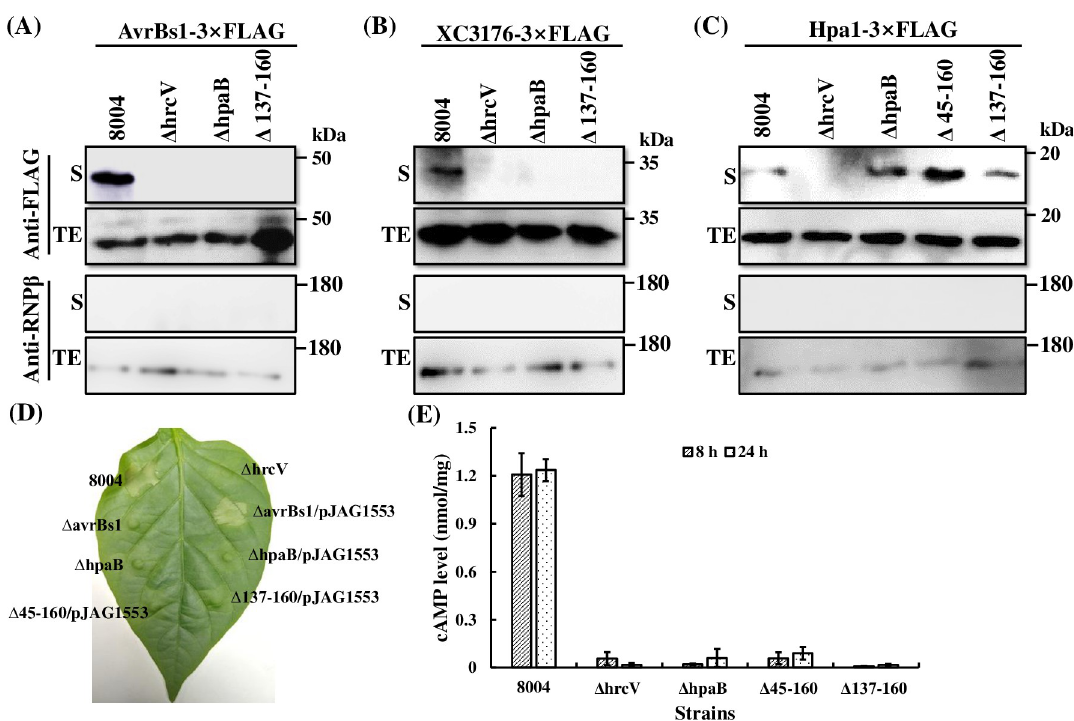
Fig 3. The C-terminal domain of HpaB is required for the secretion and translocation of T3Es in Xcc . ( A-C ) Xcc strains were incubated in hrp -inducing medium MMX. Total cell extracts (TE) and culture supernatants (S) were analyzed by immunoblotting with an ant-FLAG antibody or anti-RNP β antibody. T3Es AvrBs1 ( A ) and XC3176 ( B ) tagged with 3 × FLAG epitope tag were introduced into wild type strain 8004, T3S-defective Δ hrcV, Δ hpaB, and hpaB C-terminal deletion mutant Δ 137–160, respectively. ( C ) Non- effector Hpa1 tagged with 3 × FLAG epitope tag was introduced to wild type strain 8004, T3S-defective Δ hrcV, Δ hpaB, Δ 45–160, and hpaB C-terminal deletion mutant Δ 137–160, respectively. ( D ) Translocation assays were performed based AvrBs1 reporter. Xcc strains harboring or not with plasmid pJAG1553 expressing AvrAC 1-102 -AvrBs1 59-445 fusion were infiltrated into the expanded leaves of pepper ( Capsicum annuum cv. ECW-10R) at an OD 600 of 0.1, respectively. The phenotypes were photographed at 24 h post- inoculation. Wild type strain 8004 and Δ hpaB were used here as positive and negative control, respectively. ( E ) Translocation assays were performed with Cya reporter. Wild type strain 8004, T3S-defective Δ hrcV, Δ hpaB, Δ 45–160, and Δ 137–160, with plasmid pJAA1553 expressing AvrAC 1-102 -Cya 2-400 − 3 × FLAG fusion were infiltrated into Chinese cabbage ( Brassica oleracea cv. Jingfeng NO. 1) leaves at an OD 600 of 0.1. The cAMP level found in infected leaves was tested at 8 and 24 h post-inoculation, respectively. Values are the mean ± standard deviation from three repeats, each with 3